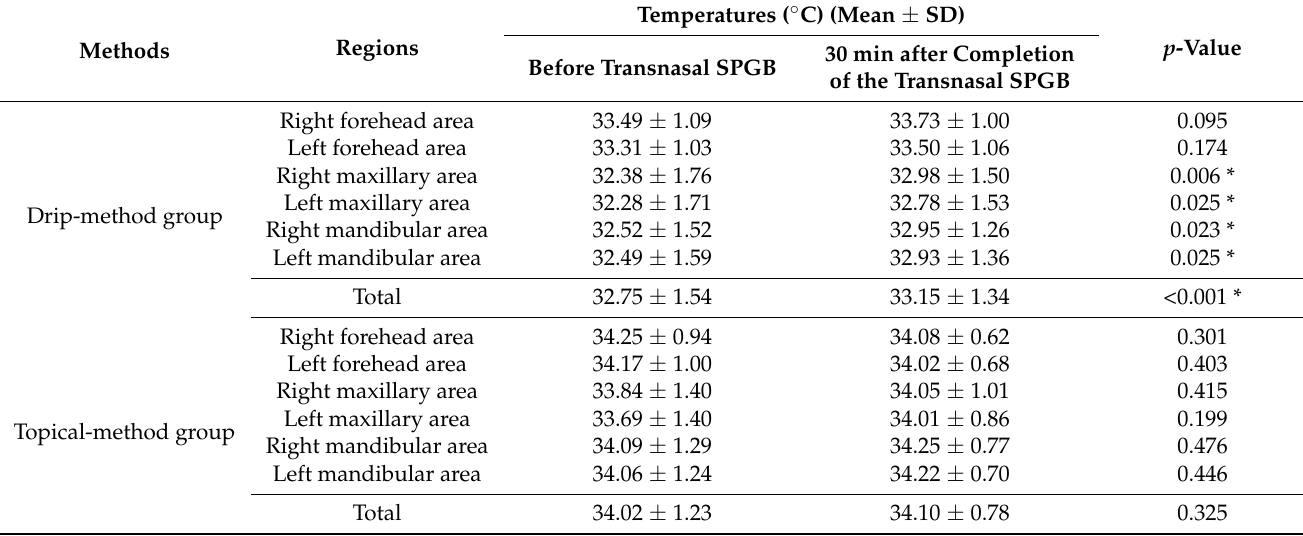
Table 3. Temperature measurements.